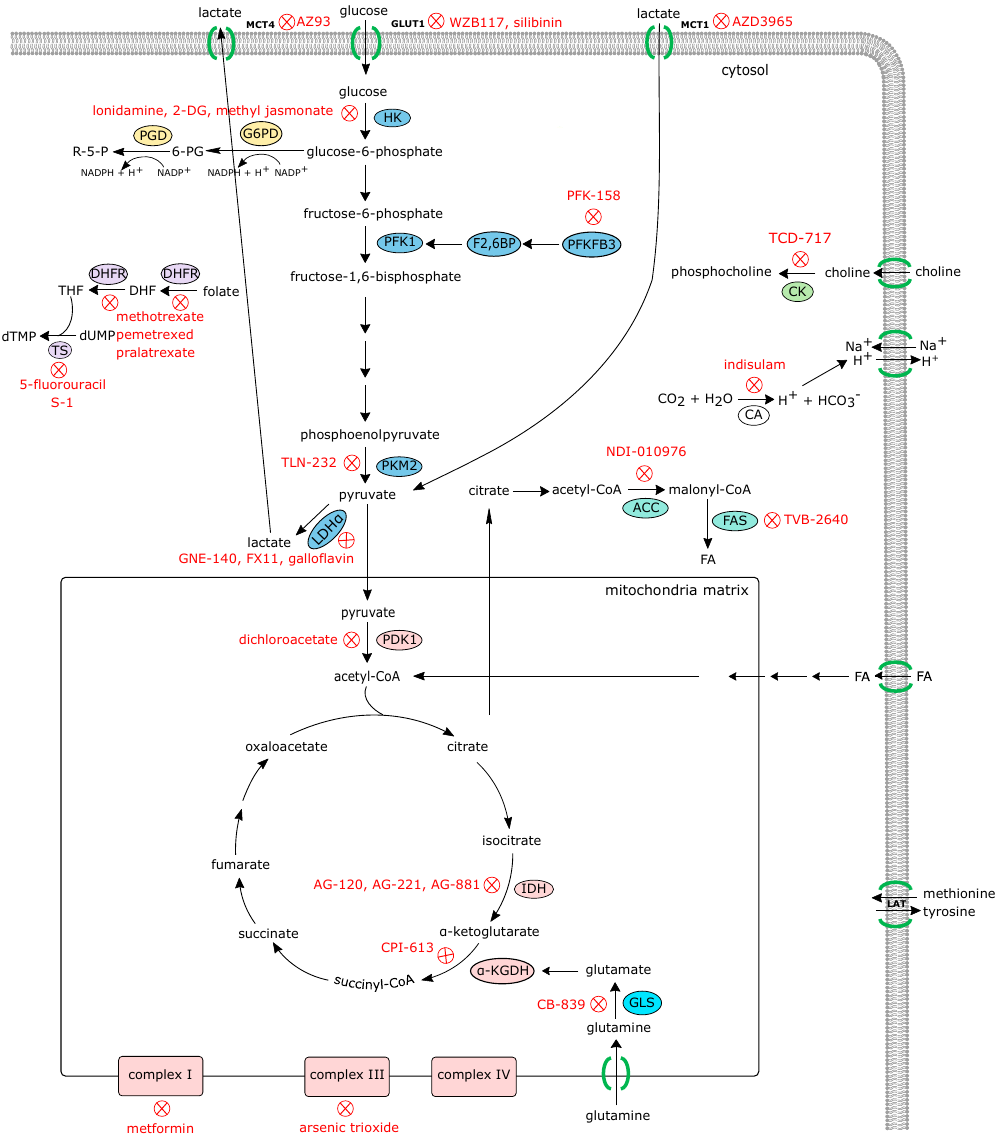
Figure 2. Anticancer agents targeting various metabolic pathways that are upregulated in activated cells. Since synovial tissue cells share many similar metabolic changes, these very same antimetabolites may also have potential uses in RA. MCT4, monocarboxylate transporter 4; GLUT1, glucose transporter 1; MCT1, monocarboxylate transporter 1; R-5-P, ribose-5-phosphate; PGD, phosphogluconate dehydrogenase; 6-PG, 6-phosphogluconate; G6PD, glucose-6-phosphate-dehydrogenase; HK, hexokinase; PFK1, phosphofructokinase 1; F2,6BP, fructose-2,6-bisphosphate; PFKFB3, 6-phosphofructo-2-kinase / fructose-2,6-bisphosphatase 3; dTMP, deoxythymidine monophosphate; dUMP, deoxyuridine monophosphate; TS, thymidylate synthase; THF, tetrahydrofolate; DHF, dihydrofolate; DHFR, dihydrofolate reductase; CK, choline kinase; PKM2, pyruvate kinase muscle isozyme M2; LDH α , lactate dehydrogenase A; CA, carbonic anhydrase; ACC, acetyl-CoA carboxylase; FAS, fatty acid synthase; PDK1, pyruvate dehydrogenase kinase 1; IDH, isocitrate dehydrogenase; α -KGDH, alpha-ketoglutarate dehydrogenase; GLS, glutaminase.